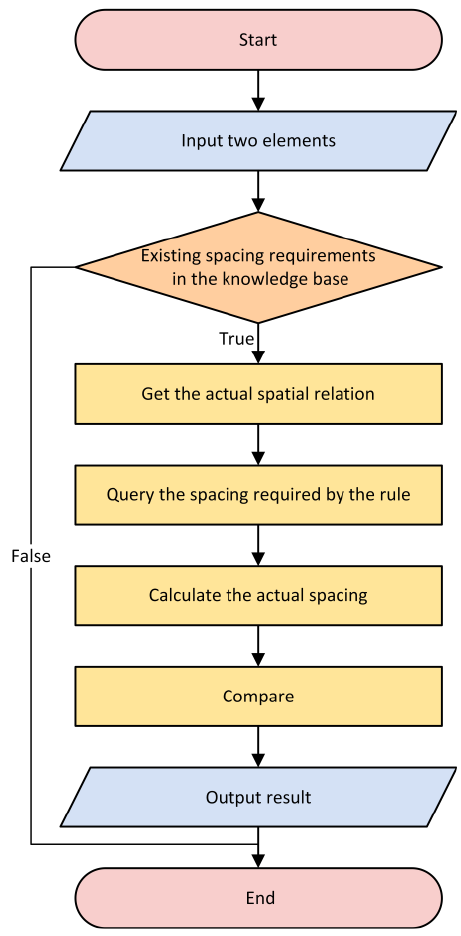
Figure 11. Algorithm for element spacing